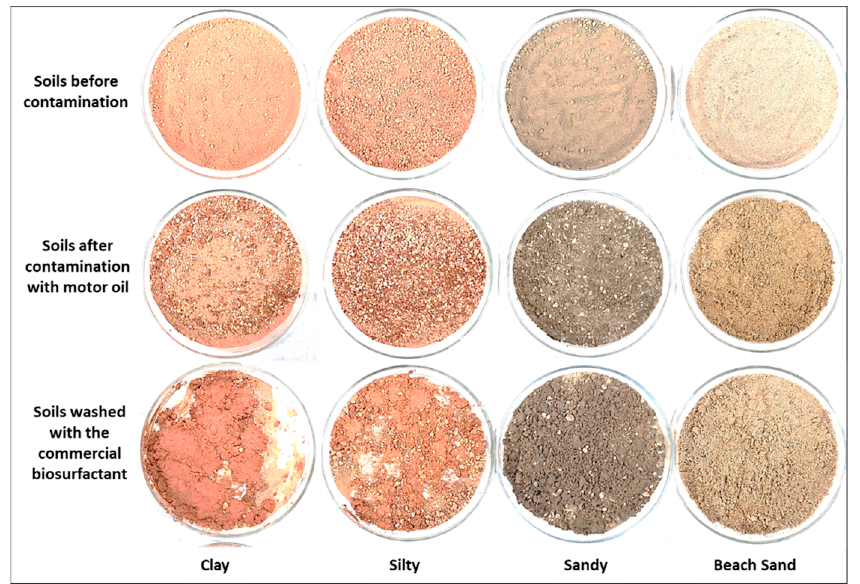
Figure 7. Illustration showing appearance of the soil samples before contamination, after contami- nation with motor oil, and washed with the formulated biosurfactant applied in static assay.